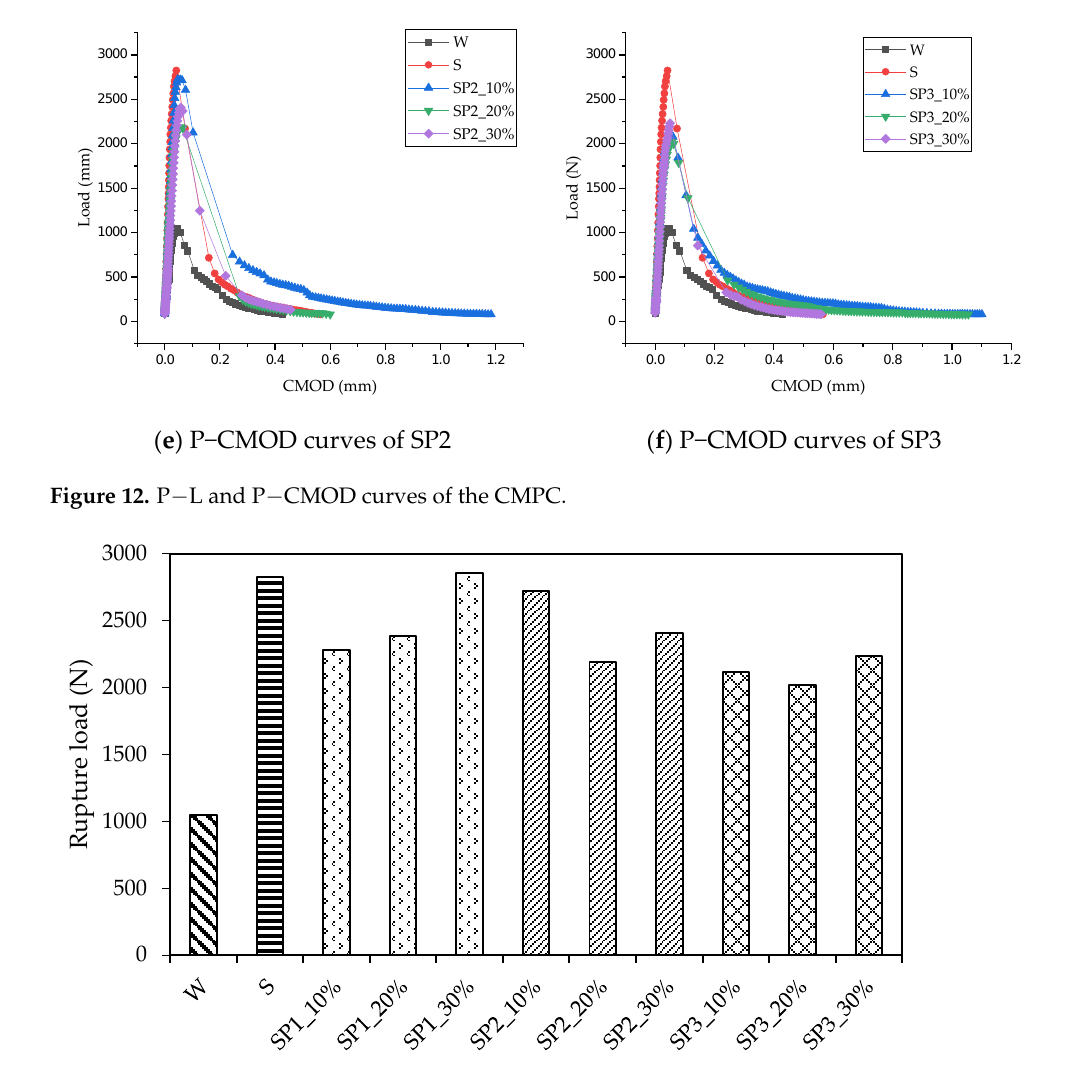
Figure 13. Rupture load of the fracture toughness test. Table 7. Fracture energy vs. fracture